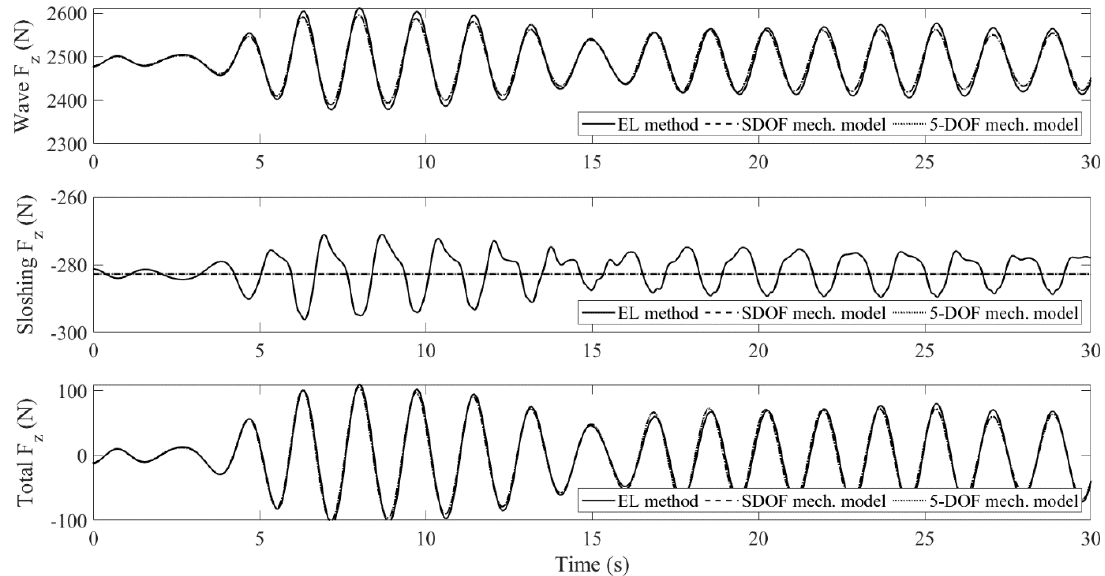
Figure 11. The vertical forces acting on the floating body for the large-wave case.